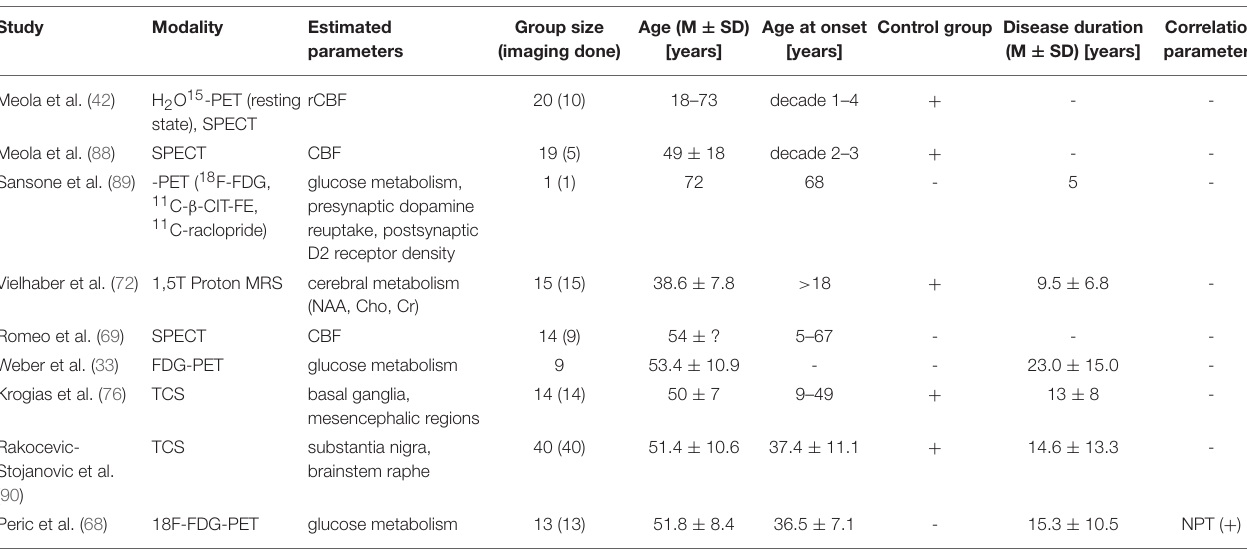
TABLE 8 | Functional brain imaging in